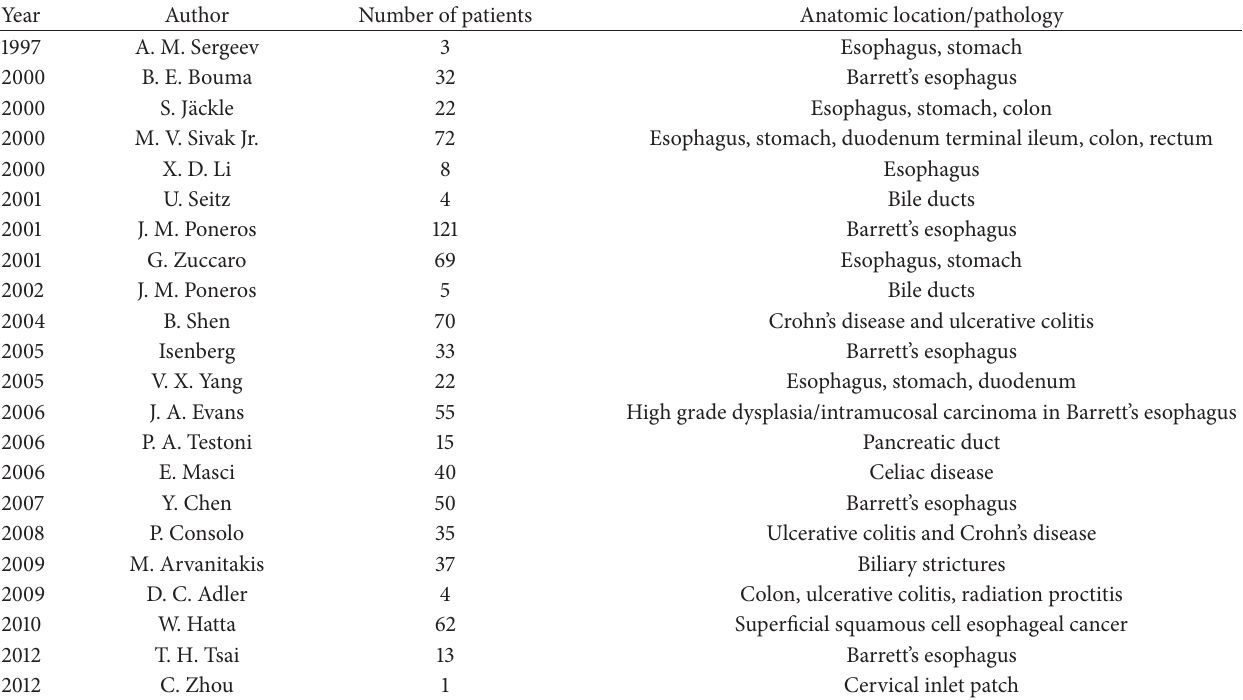
Table 1: In vivo OCT studies in the human gastrointestinal